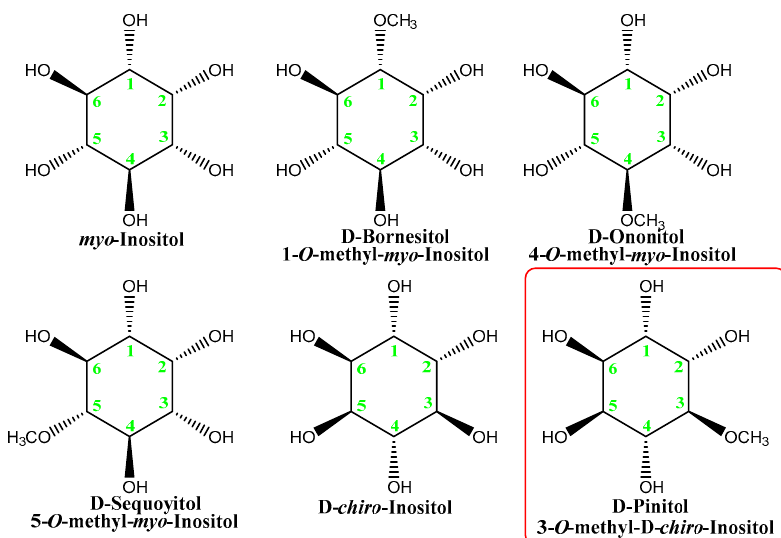
Figure 7. Inositols and their methyl ethers isolated from Carob. 3. D-Pinitol: Occurrence, Isolation, and Properties